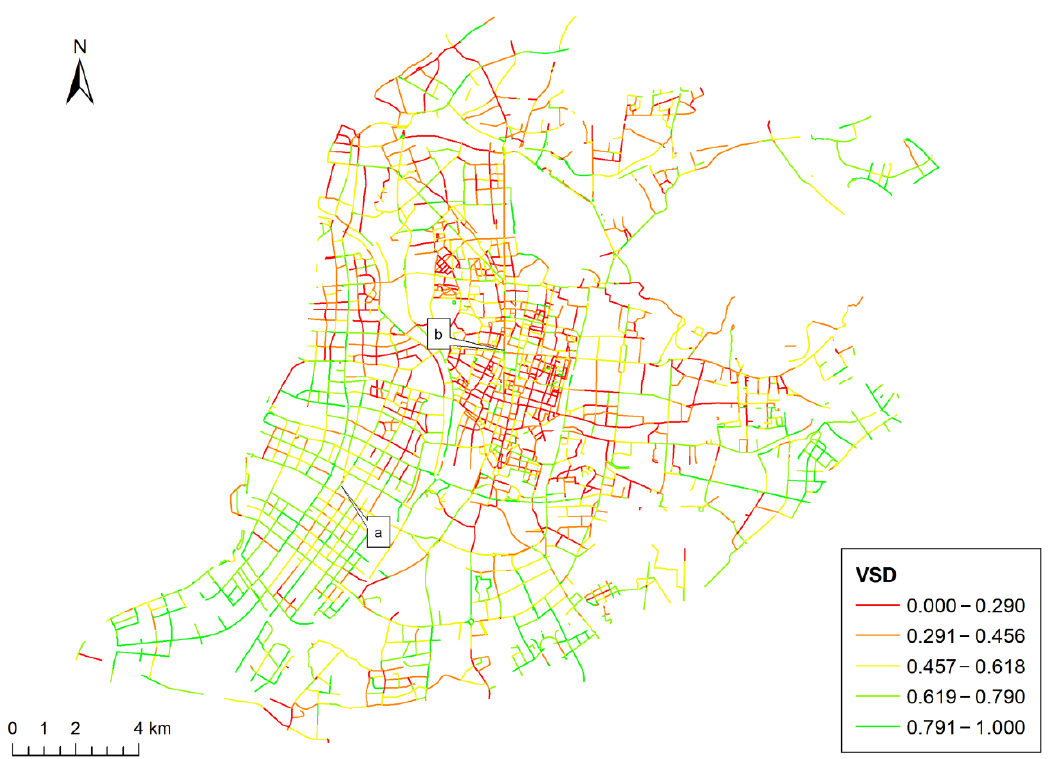
Figure 13. Street–level vegetation structural diversity (VSD) distribution. Levels were classified by the natural break method.